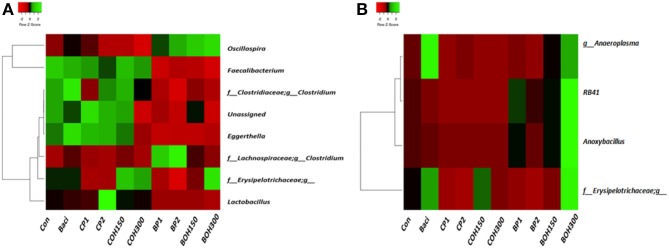
Heatmap showing bacterial genera whose relative abundances were significantly (P < 0.05) changed by studied dietary treatments in (A) ceca and (B) cloacae.